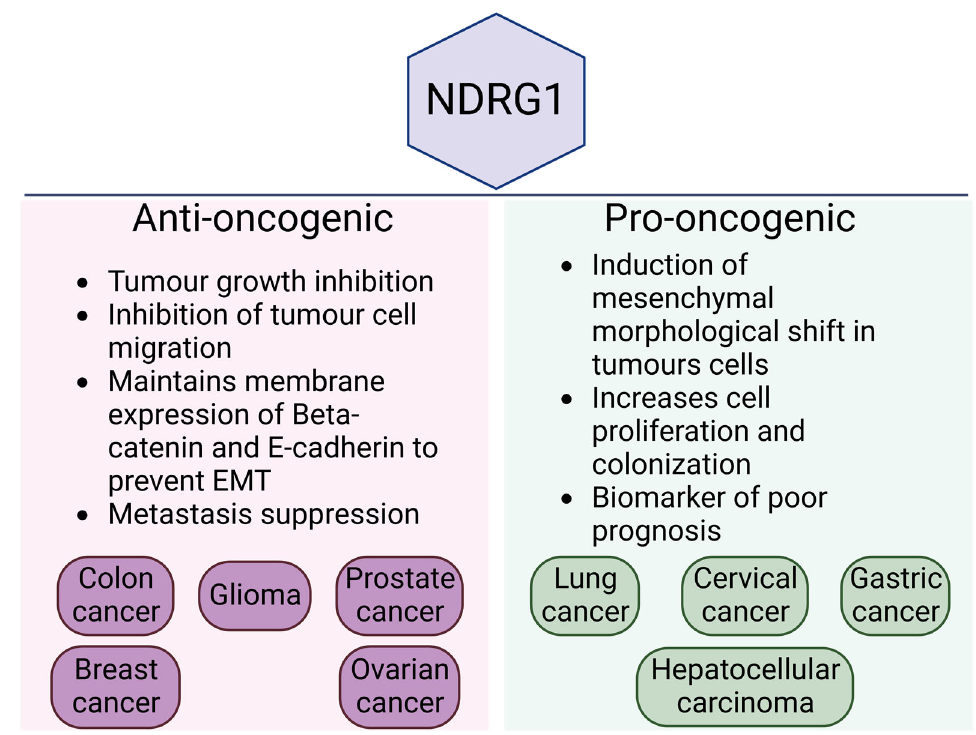
Figure 3. NDRG1 and its anti/pro ‐ oncogenic roles in different cancer.